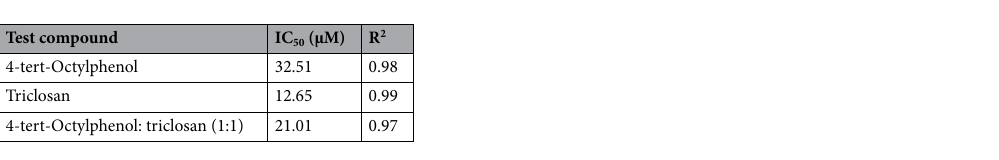
Table 1. IC 50 values for cytotoxicity against INS-1